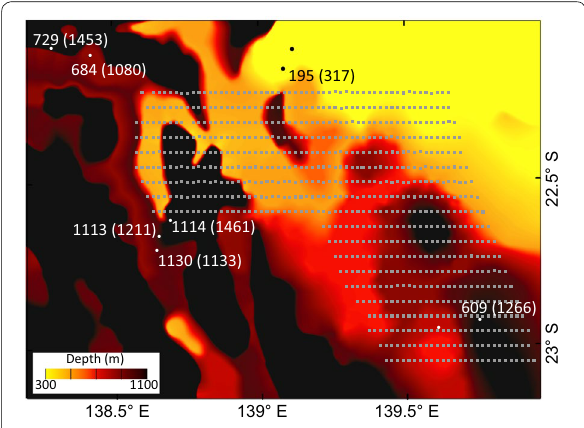
Fig. 2 Frogtech Geoscience (2018) depth to basement interpretation for the study area. Selected drillholes annotated with actual basement depth, predicted Frogtech basement depth in